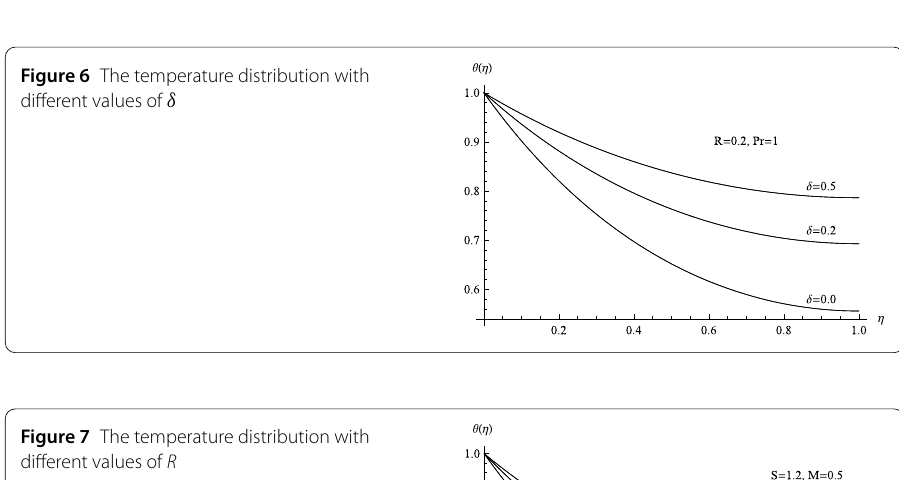
Figure 7 The temperature distribution with different values of